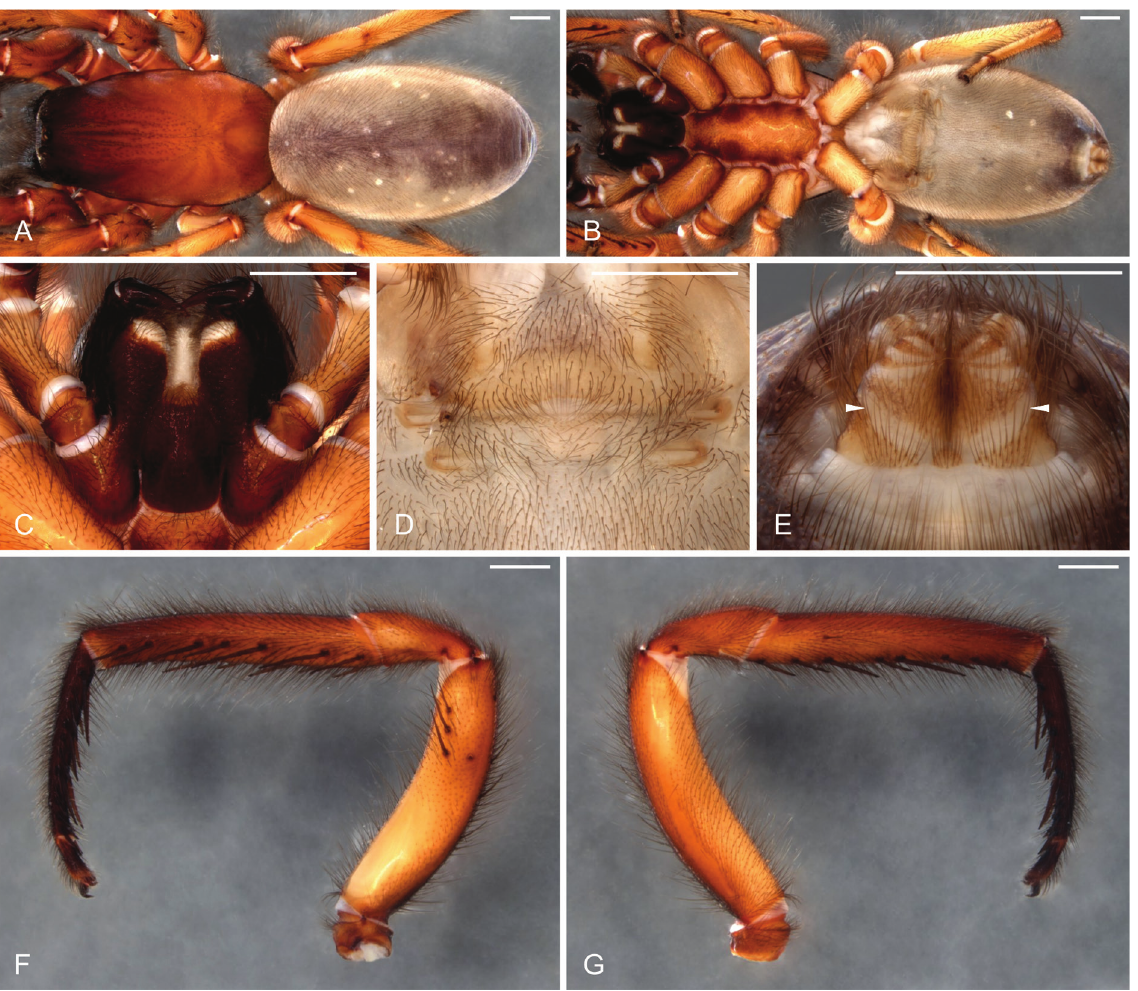
Fig. 2. Ariadna motumotirohiva sp. nov., ♀, holotype (MNHN 8366). A . Habitus, dorsal view. B . Habitus, ventral view. C . Endites, labium and labrum, ventral view. D . Epigastric furrow, ventral view. E . Spinnerets, ventral view, arrowheads showing the diagonal membranous stripes of the ALS. F . Right leg I, prolateral view. G . Right leg I, retrolateral view. Scale bars = 1